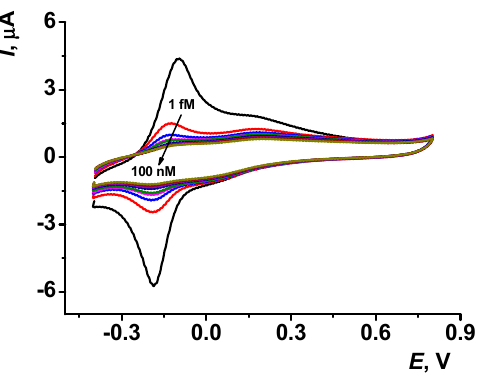
Figure 8. Cyclic voltammograms recorded on the GCE covered with the PAB-2/DNA-MB film prior to and after 20 min incubation in 1 fM, 10 fM, 100 fM, 1 pM, 10 pM, 100 pM, 1 nM, 10 nM, 100 nM idarubicin solution, 0.1 M HEPES buffer containing 0.03 M NaCl, pH 7.0.